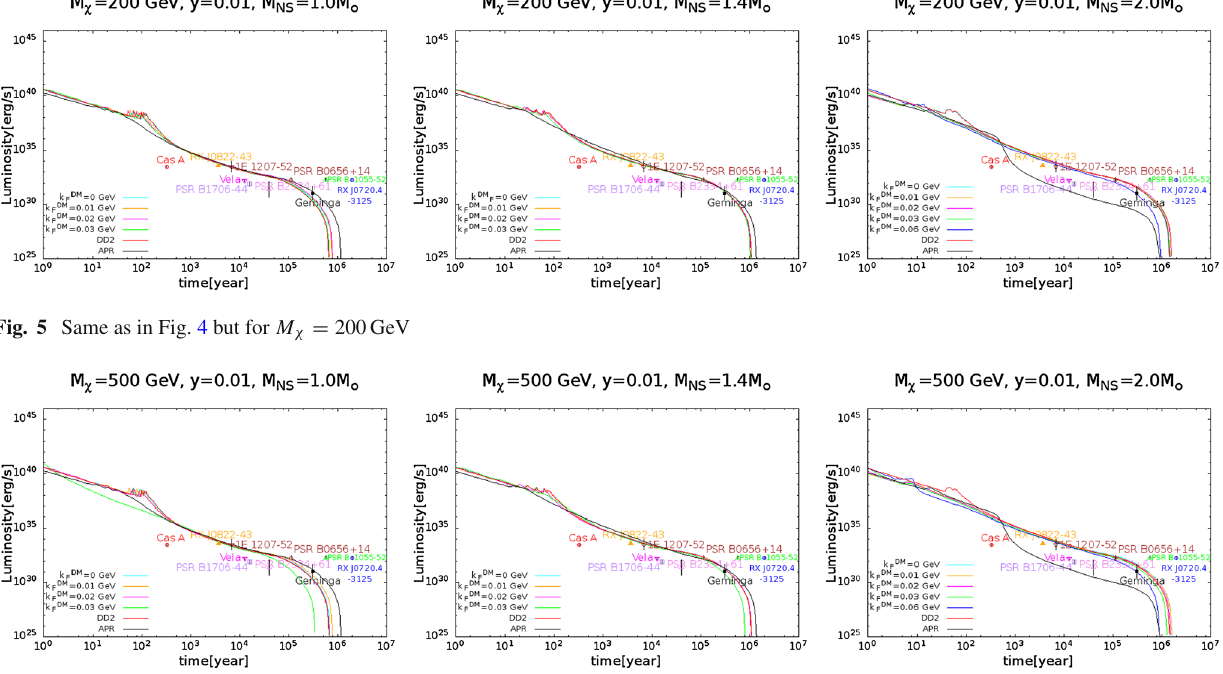
Fig. 6 Same as in Fig. 4 but for M χ =